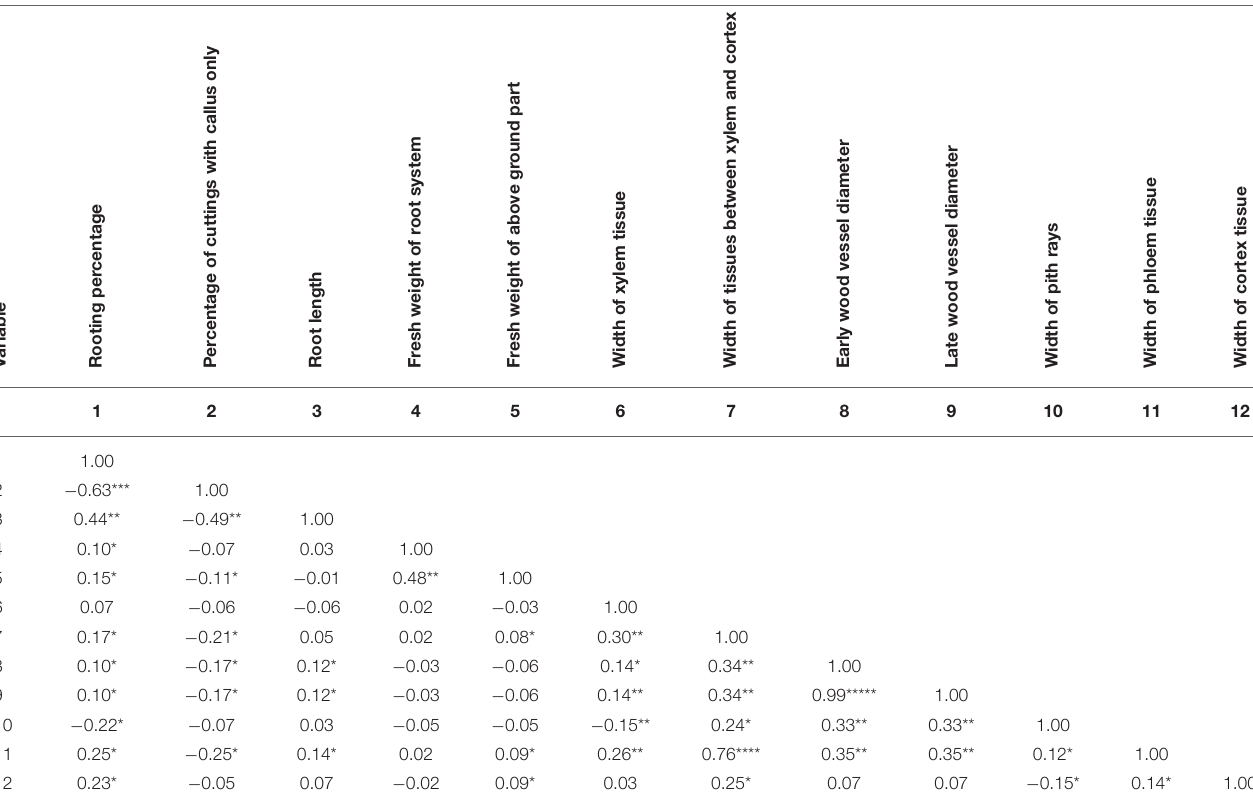
TABLE 2 | Effect correlations between measured parameters of growth and anatomical structure in Rosa “Hurdal” after 25 days of rooting cuttings in all phases taken